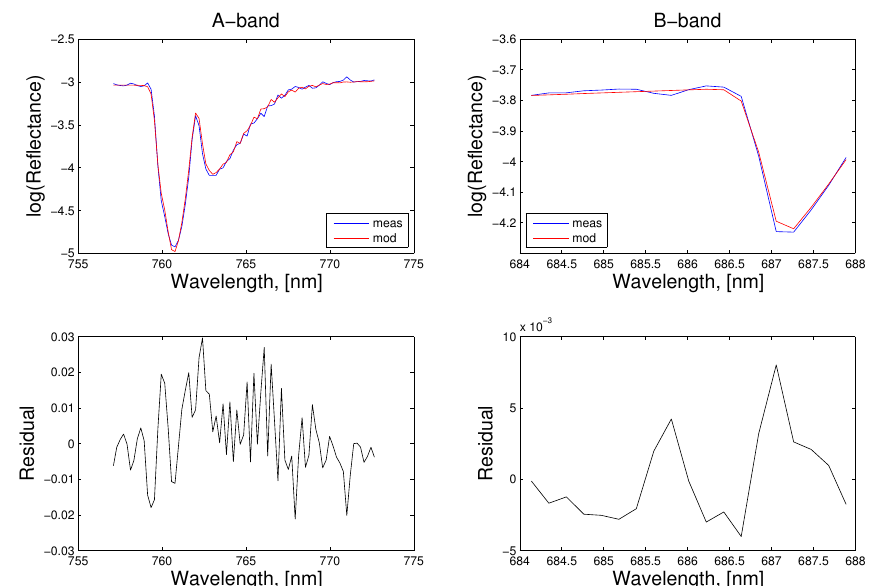
Fig. 8. A fit showing the O 2 A- and B-band spectra simulated by the forward model (red) against the spectra measured by SCIA- MACHY(blue), in the upper left and right panels respectively. The log(Reflectance) indicates the natural logarithm of the measured and modeled reflectances. The bottom panels show the corresponding dimensionless residuals of the two spectra relative to the